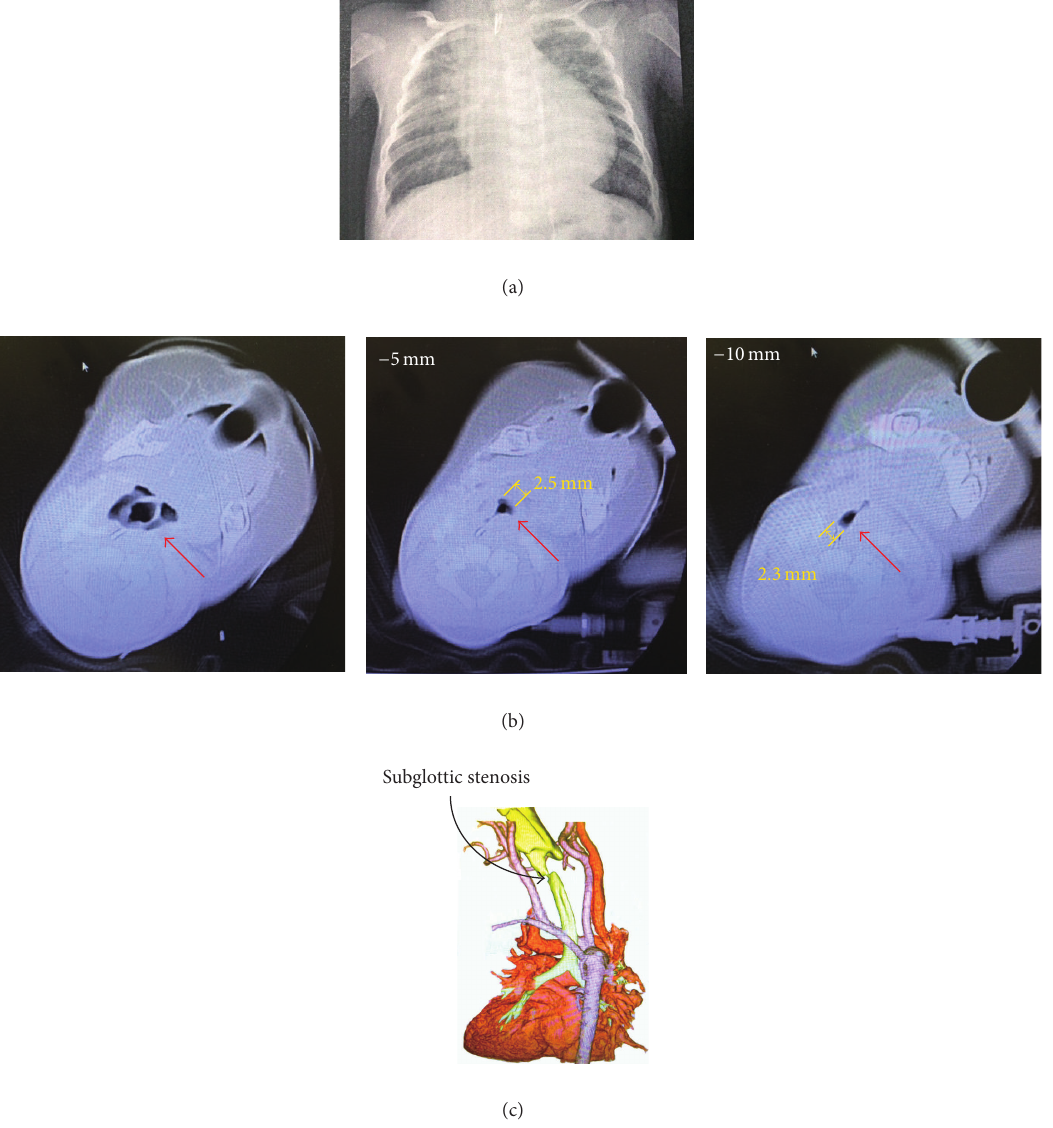
Figure1:ChestX-rayposterior-anteriorviewandcomputedtomographicimages.(a)ChestX-rayposterior-anterior(PA)view.(b)Computed tomographic (CT) images of the neck region (every 5 mm). Left panel: level of the larynx. Center panel: − 5mm from the level of the larynx. Right panel: − 10mm from the level of the larynx. (c) Three-dimensional CT reconstruction image of the larynx and vessels. The arrow shows subglottic